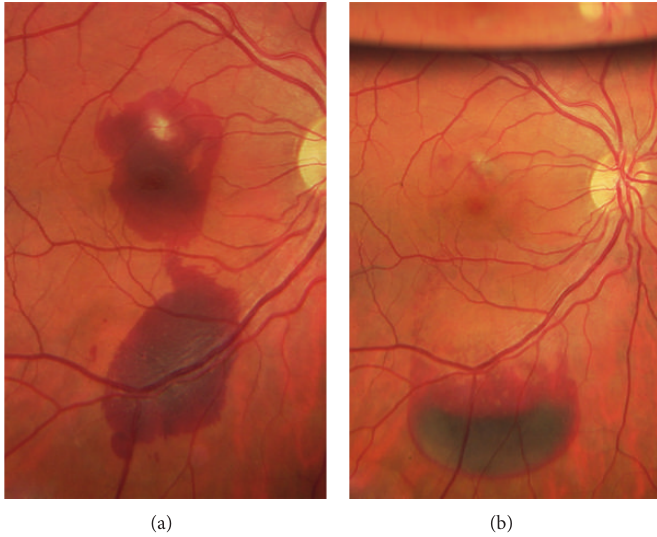
Figure 2: (a) Color photograph of the right eye two days after focal thermal laser. At initial examination, visual acuity (VA) was 20/200 (ETDRS chart) and a subretinal subfoveal hemorrhage with the greatest linear diameter (GLD) of 4.500 𝜇 was seen. (b) Color photograph after pneumatic displacement with intravitreal tissue plasminogen activator (IVTPA) combined with pure C3F8. At 24 hours, the hemorrhage had been displaced inferiorly and VA improved to 20/100. Two weeks after pneumatic displacement with C3F8 and IVTPA, VA improved to